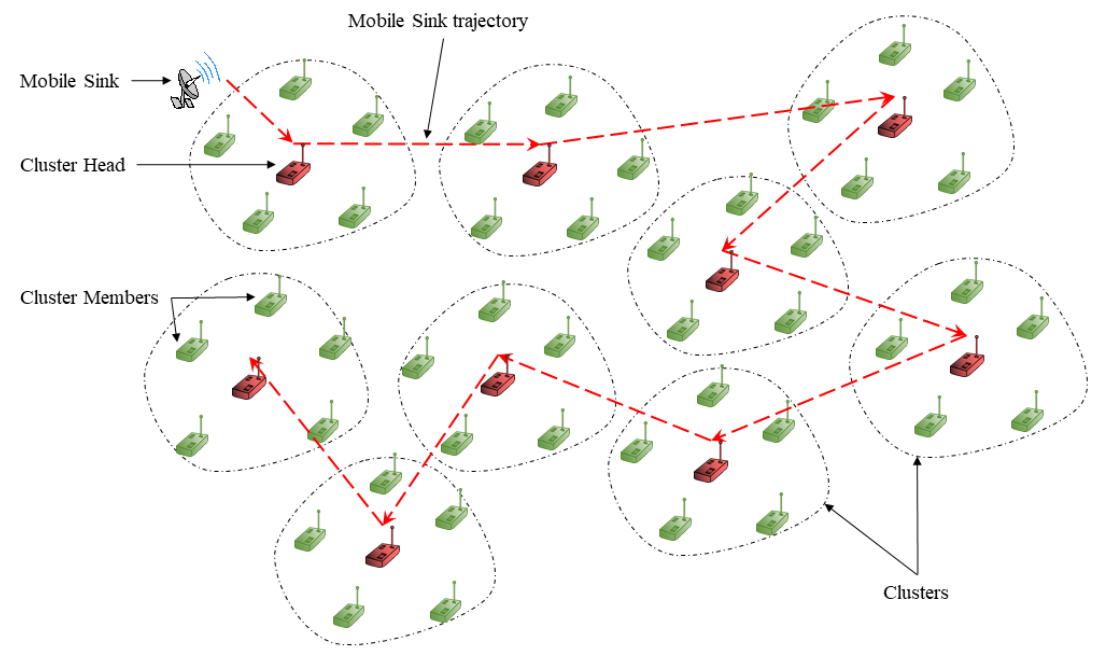
Figure 2. moving plan in Cluster-Based Wireless Sensor Network. Figure 2. Moving plan in Cluster-Based Wireless Sensor